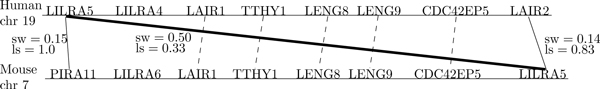
BBH-LS mislead by high local synteny. BBH-LS paired LILRA5 (human) with PIRA5 (mouse) and LAIR2 (human) with LIRA5 (mouse) due to the high local synteny produced by the five pairs of genes in between. The correct pairing should be LILRA5 (human) with LILRA5 (mouse) and this was picked up by BBH using just the normalized Smith-Waterman score.